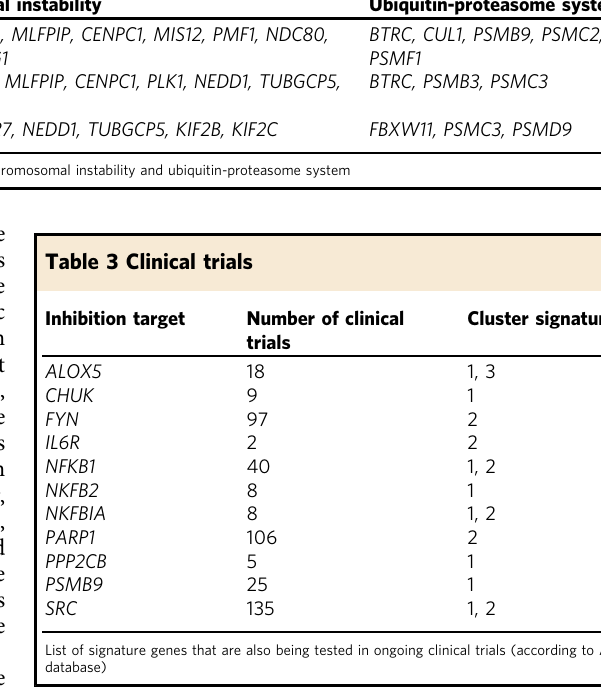
Table 2 Common biological categories in gene signatures NF- κ B